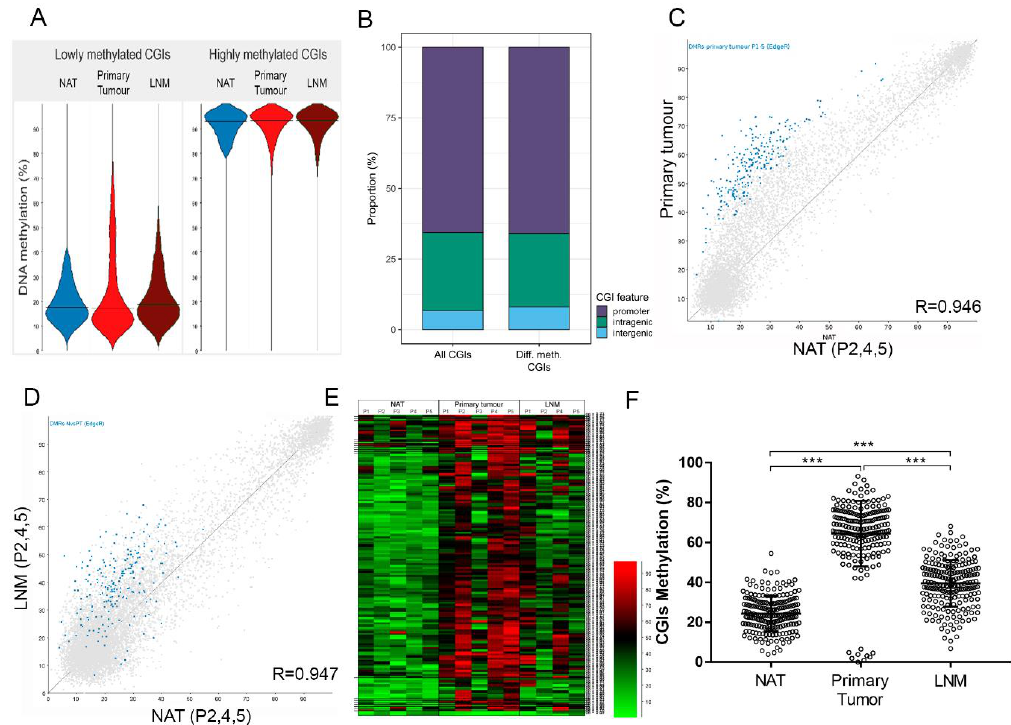
Figure 2. CGI methylation levels in normal adjacent tissue, primary tumour and lymph node metastasis samples of CRC patients. ( A ) Beanplots showing DNA methylation levels of lowly ( < 40%) and highly ( > 80%) methylated CGIs ( n = 9776). ( B ) Bar chart showing the proportion in which di ff erent CGI features are represented in all analysed CGIs ( n = 7009) and in di ff erentially methylated CGIs ( n = 246). ( C ) Scatterplot comparing DNA methylation levels of CGIs between NAT and primary tumour samples and ( D ) between NAT and LMN samples in which each dot represents a CGI ( n = 7009). Di ff erentially methylated CGIs are highlighted in blue. ( E ) Heatmap showing methylation levels of 246 di ff erentially methylated CGIs for each individual patient. Each bar represents a CGI and the colour scale indicates its methylation level. ( F ) Strip chart comparing methylation percentage of 204 CGIs in NAT, primary tumour and LNM samples (1.5 kb upstream to coding-genes) (*** p <